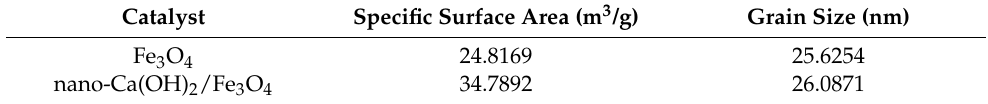
Table 1. Comparison of the grain structure and specific surface area of Fe 3 O 4 and nano-Ca(OH) 2 /Fe 3 O 4 .